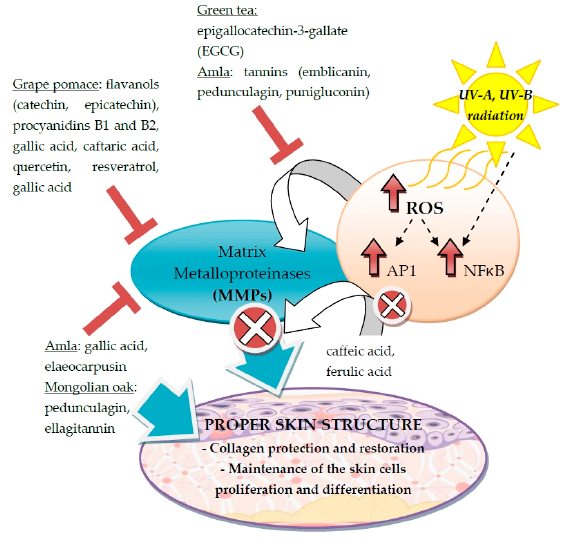
circle and the red signs in the letter “T” shape indicate the inhibition of the MMPs